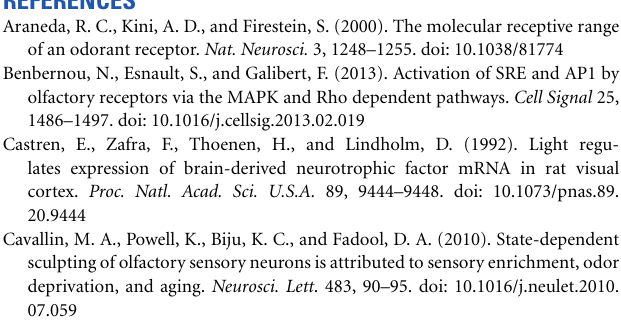
Figure 2B 1 pathway. The tracking of the two dots used for scalar quantification is incrusted within the video. Additional file 2 | List of primers used for qPCR analyses. Additional file 3 | Melting curves of primer pairs used for qPCR analyses. Additional file 4 | Illustration of TUNEL area quantification on images presented in Figure